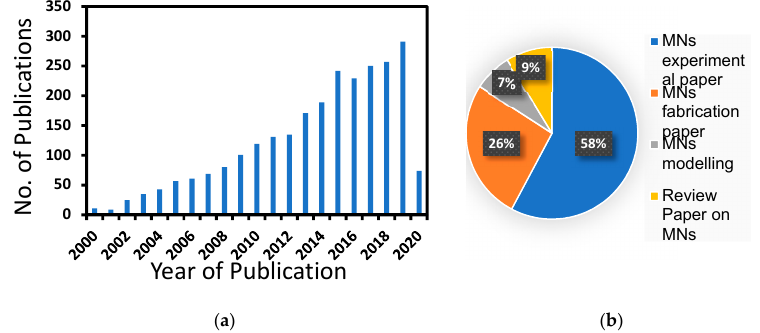
Figure 1. ( a ) Number of journal articles published related to microneedles (MNs) according to Scopus in between 2000–2020, ( b ) distribution of papers according to different MN applications (accessed on